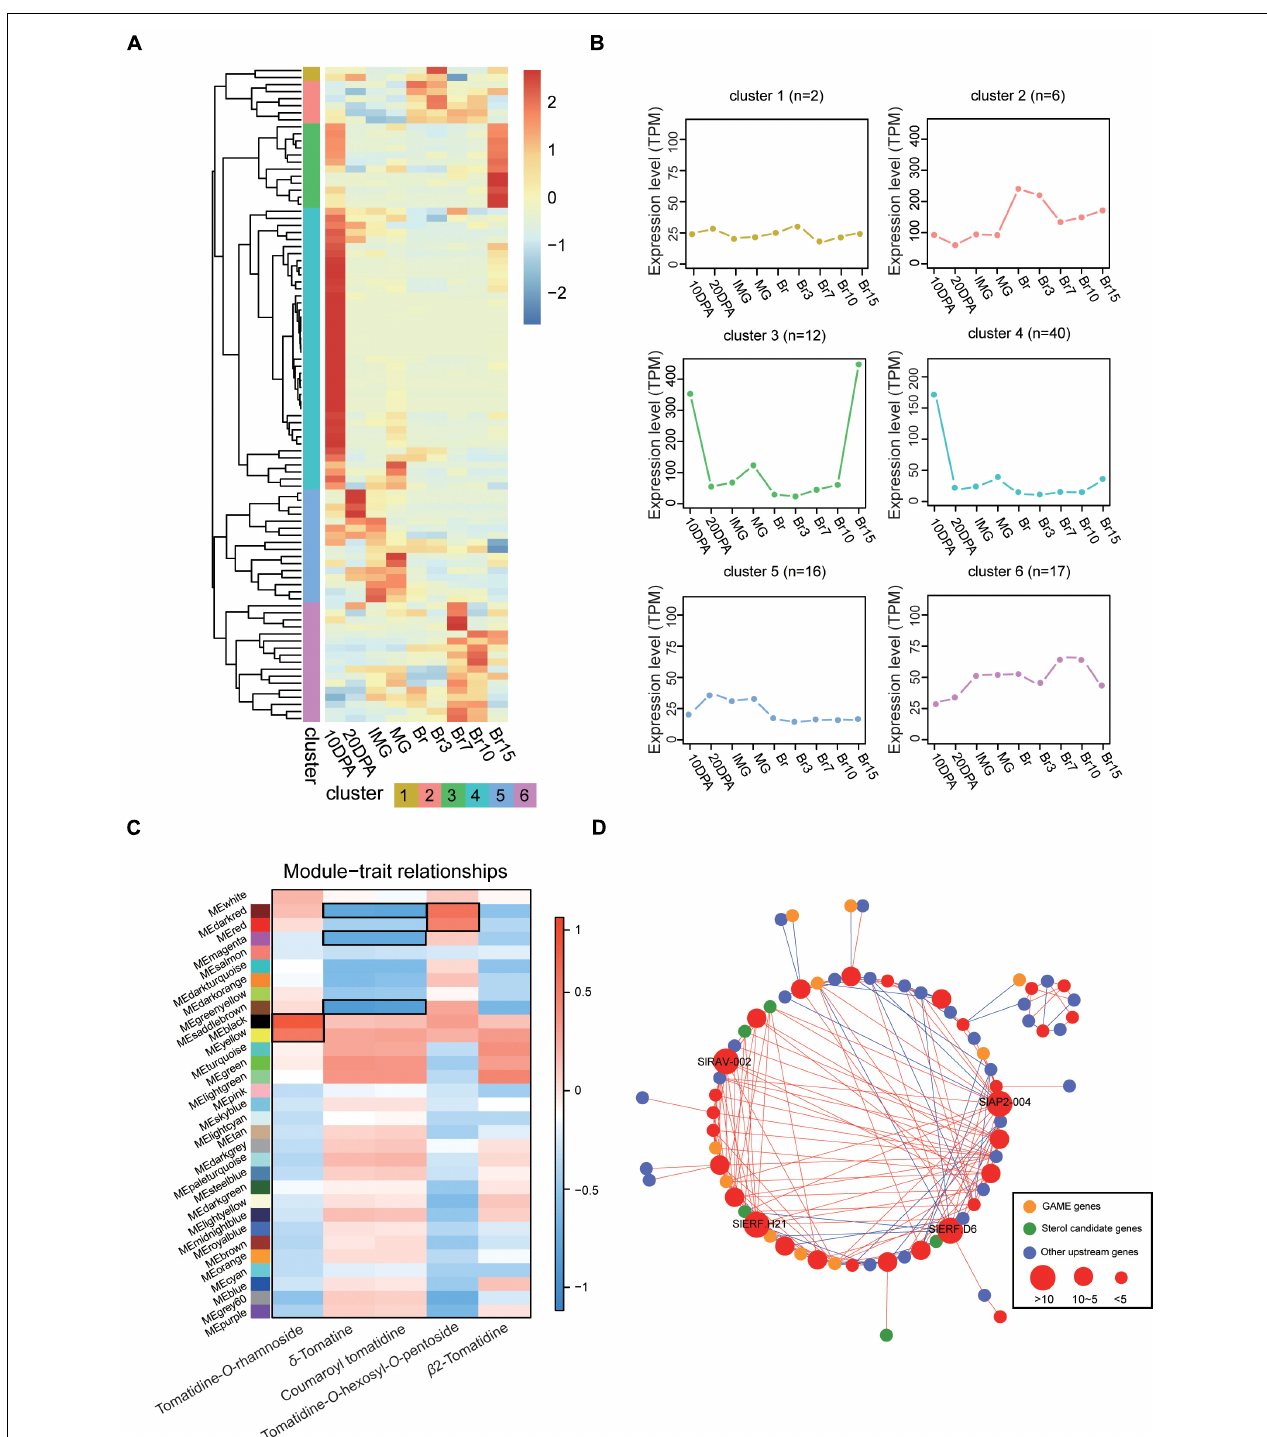
FIGURE 2 | RNA-seq analysis of ERF genes during fruit development. (A,B) Expression pattern of the ERF genes during the fruit development of tomato. The gradient color (blue to red) in the heatmap represents the transcription level after normalization, and other colors represent different clusters. (C) Module-sample association. Each row corresponds to a module with different colors, labeled with a color as in Supplementary Figure 9 . The color of each cell at the row–column intersection indicates the correlation coefficient between the module and the steroidal glycoalkaloids (SGAs) content, and the modules with black border represented that they are highly correlated with SGAs. (D) Analysis of co-expression between SlAP2/ERF genes and other SGA related genes. Different colored circles represent different genes, red is the AP2/ERF identified in this study, and different circle sizes are the number of their high correlation with other genes.